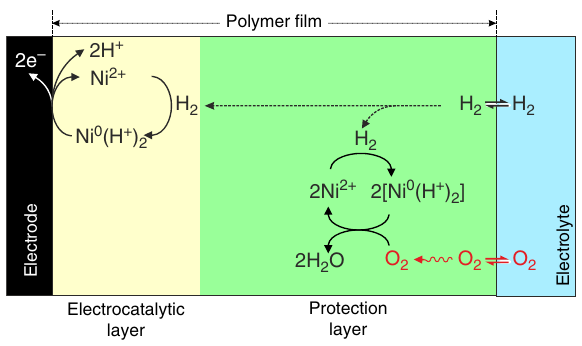
Fig. 3 Proposed reactions inside the polymer/catalyst fi lm. Schematic representation of the polymer fi lm separating the immobilized CyGly complex into two functional layers where different reactions occur; colors are used to identify the different polymer layers and the boundary between polymer and electrolyte. In the electrocatalytic layer (yellow), H 2 is oxidized to protons and electrons via the Ni-complex. Within the protection layer (green) the doubly reduced Ni 0 complex catalyzes the reduction of incoming O 2 to H 2 O by using the electrons supplied from H on the electrode surface, but also prevents electrical contact between the complexes in the remote regions of the fi lm and the electrode. The formation of a suf fi ciently thick polymer fi lm generates two distinct regions; with electrocatalytic H 2 oxidation in the inner layer near the electrode surface and O 2 reduction in the outer layer as shown in Fig. 3.